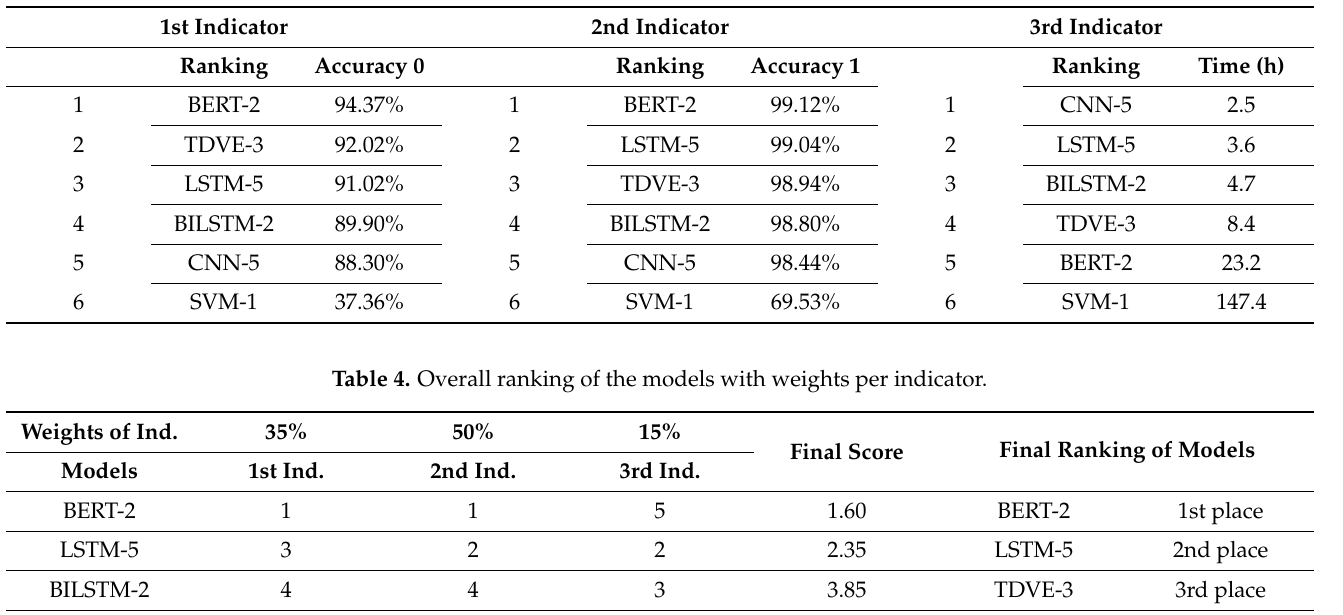
Table 3. Performance results summary of the models per indicator.